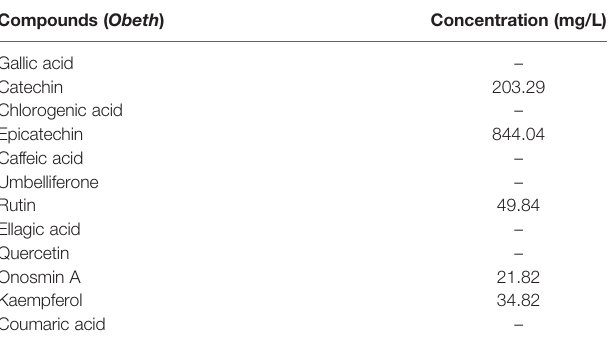
TABLE 2 | Amount (mg/L) of different phytochemical quanti fi ed by HPLC in different Obeth of O. bracteata . Compounds ( Obeth )